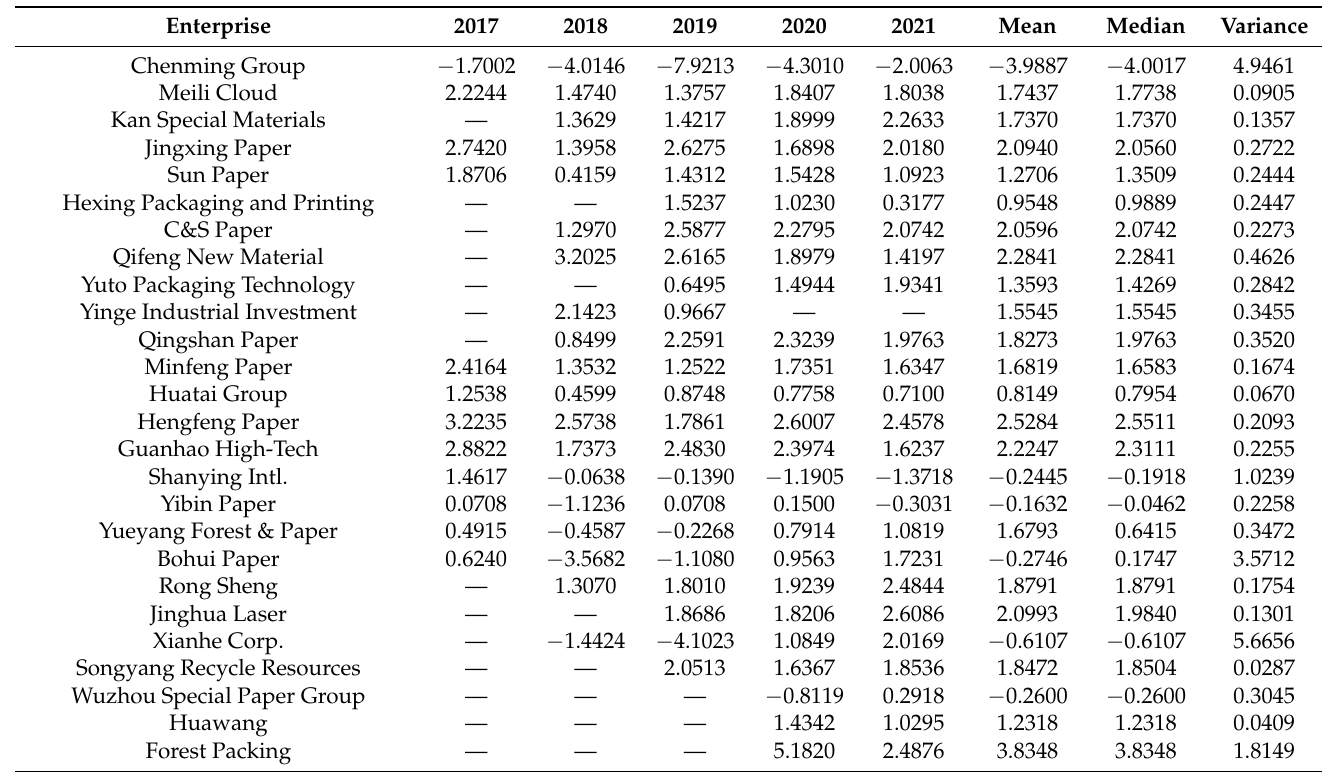
Table 3. Default distances of listed enterprises in the paper industry from 2017 to